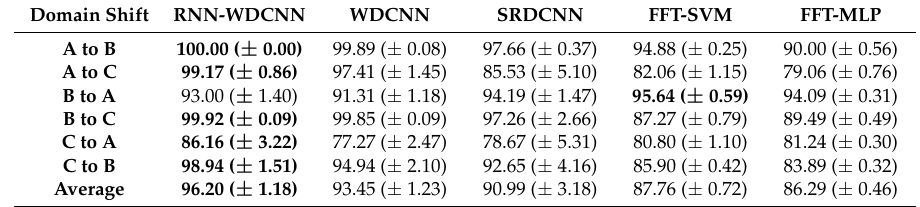
Table 7. Recall scores of the models considered in this work (as a percentage) for the domain adaptation task considered in scenario 1 (best values are highlighted in bold).